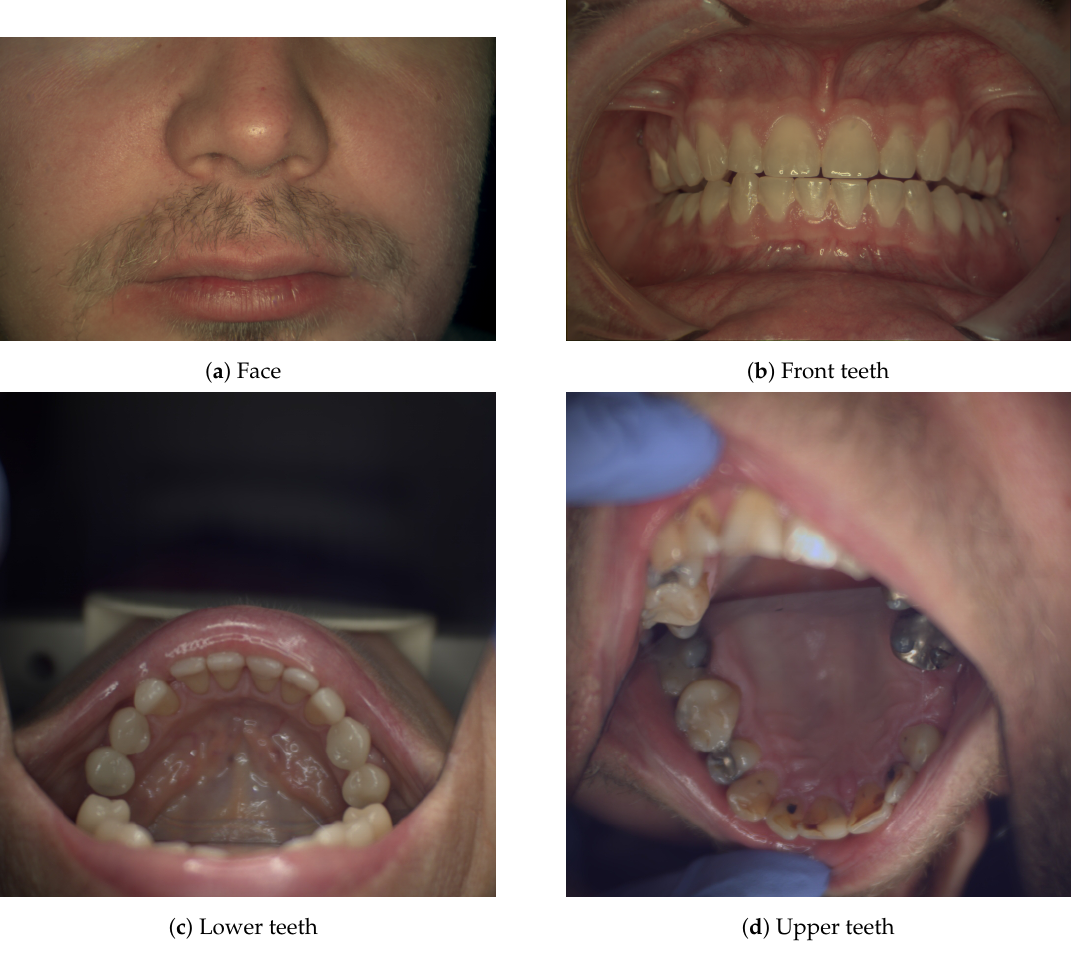
Figure 3. Representational example image set consisting of the base set of spectral images acquired of every test subject. Images ( c , d ) demonstrate the use of a dental mirror in